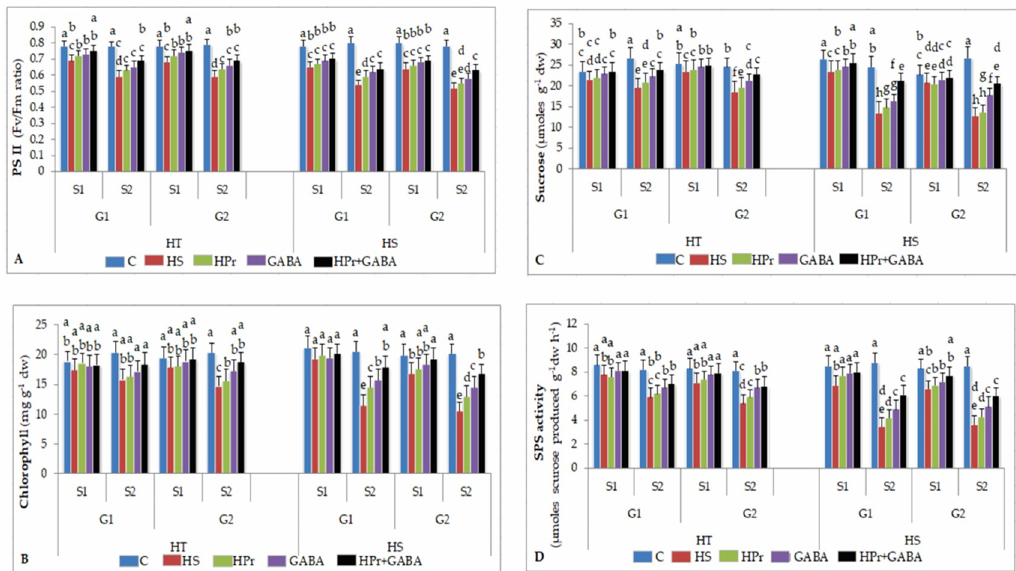
Figure 4. Effect of heat priming (HPr) and γ -amino butyric acid (GABA), applied individually or in combination (HPr+GABA) on photosystem (PS) II function ( A ), chlorophyll content ( B ), sucrose ( C ) and sucrose phosphate synthase, SPS ( D ) on heat-tolerant (G1: IG2507; G2: IG3263) and heat-sensitive (G1: IG2821; G2: IG2849) genotypes at stage 1 (S1) and stage 2 (S2) in heat-stressed (HS) lentil plants, compared to control ( C ). Vertical bars represent standard errors ( n = 3). Different small letters on the bars indicate significant differences from each other ( p < 0.05). LSD for interaction (genotypes × stages × treatments) ( p < 0.05): photosystem II: 0.039, chlorophyll content: 1.9; sucrose: 2.3, sucrose phosphate synthase: 0.91. dw = dry